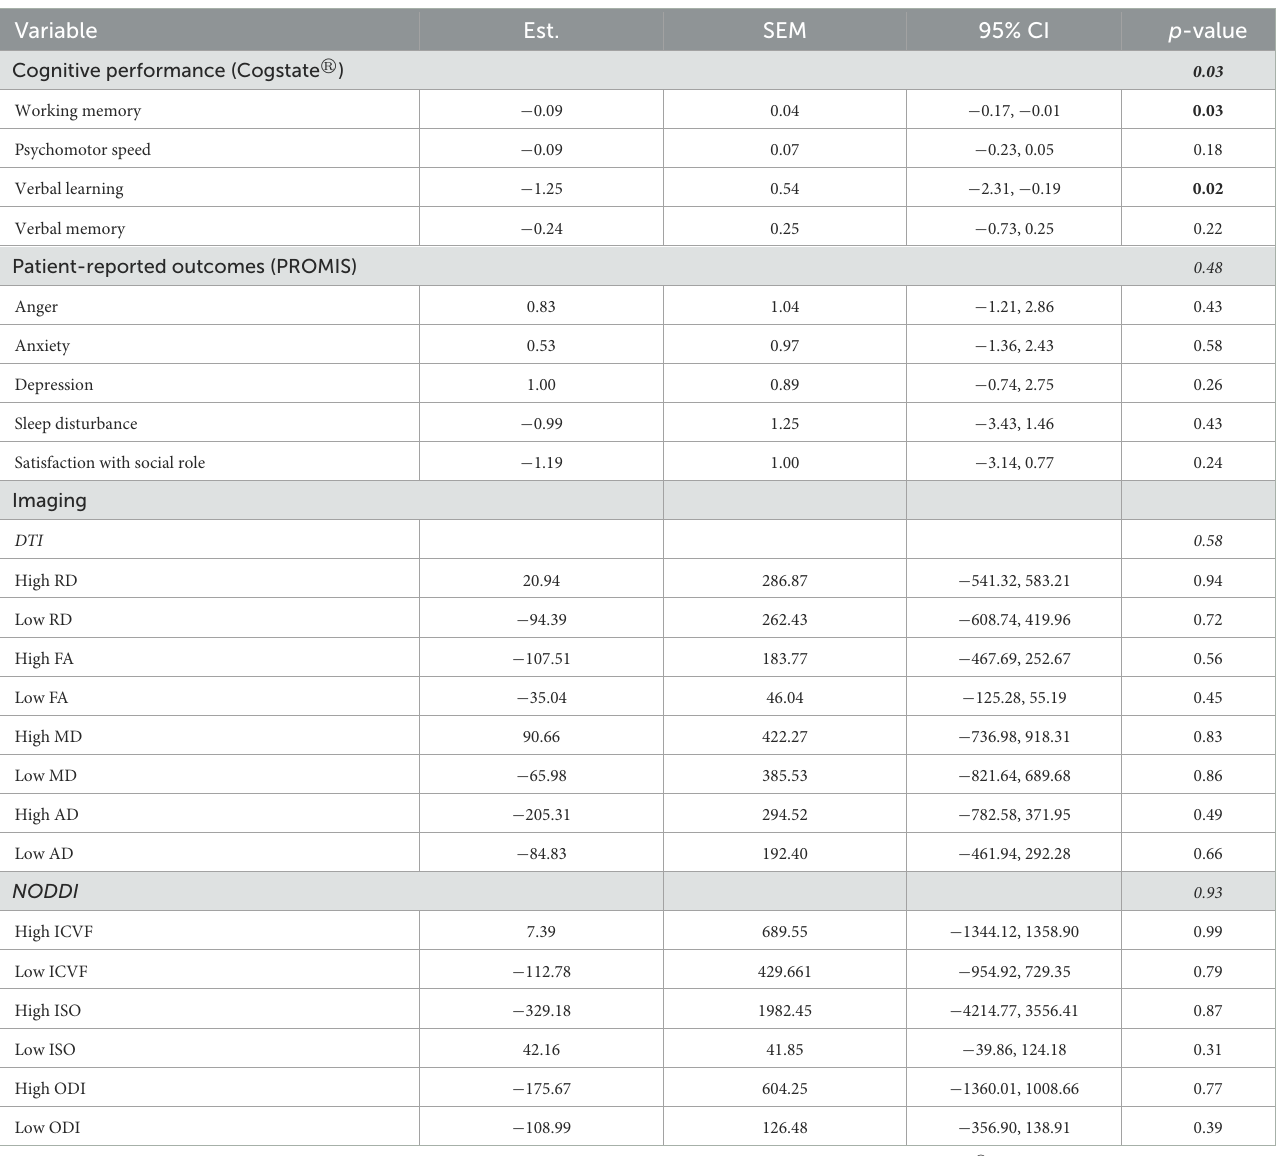
TABLE 2 Linear mixed effects models results summary.